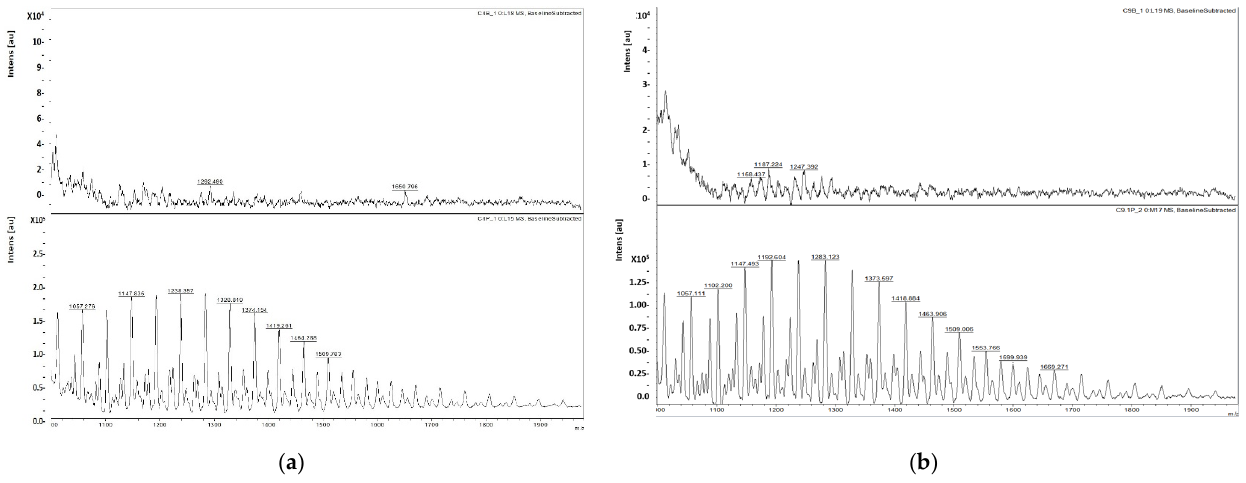
Figure 6. Mass spectrum of the crude extract biosurfactant produced by the bacterial strains: ( a ) Pseudomonas rhodesiae strain C4 and ( b ) Pseudomonas marginalis strain C9.